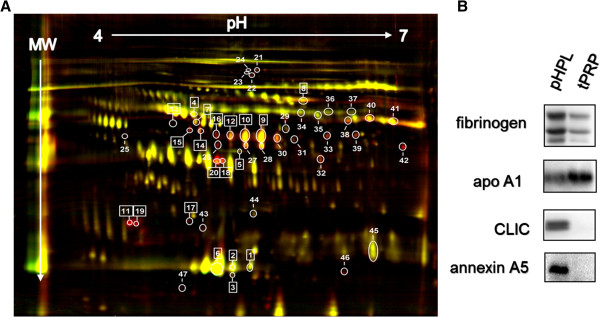
Proteomics and western blot verification. (A) Differential 2D-DIGE proteome map of pHPL and tPRP platelet derivatives containing bioactive factors. Differential proteins spots (a total of 47) were detected by utilizing strips from pH 4 to 7 and quantitative Delta 2D imaging software (t-test p ≤ 0.05). Proteins identified by mass spectrometry are specifically shown (no. in rectangle). (B) Complementary Western blot verification of differential proteins in albumin and IgG depleted pHPL and tPRP samples. Different protein concentrations were loaded: α-fibrinogen (2.5 μg protein/lane), α-apoA1 (2.5 μg protein/lane), α-CLIC (5 μg protein/lane), α-annexin A5 (30 μg protein/lane).